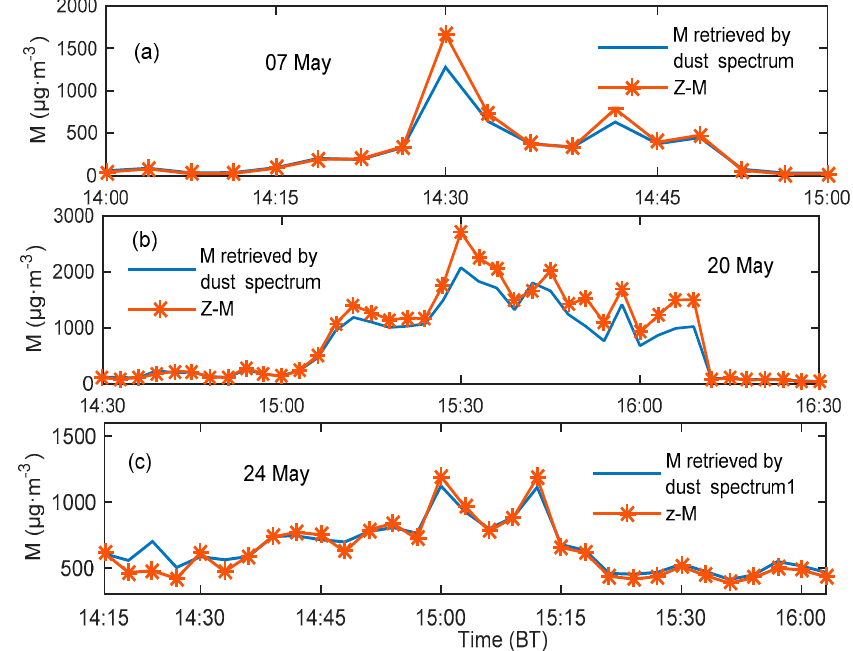
Figure 11. The temporal distribution of dust mass concentration at a height of 200 m. ( a ) 14:00–15:00 on 7 May; ( b ) 14:30–16:30 on 20 May; ( c ) 14:15–16:00 on 24 May.